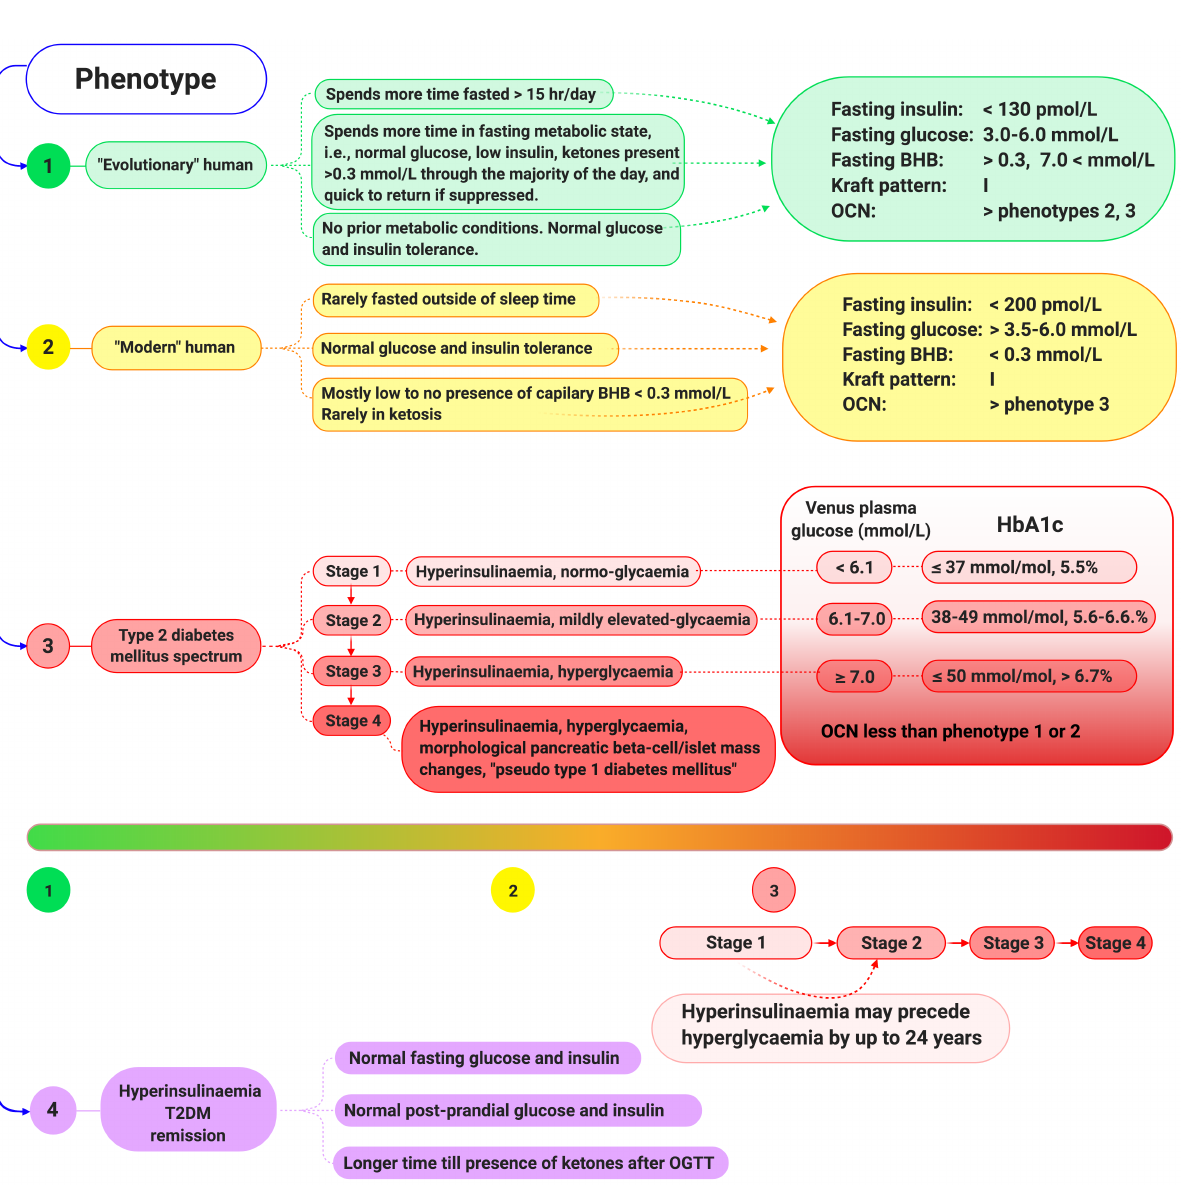
Figure 3. Classification of metabolic phenotypes. Beta-Hydroxybutyrate (BHB), haemoglobin A1c (HbA1c), oral glucose tolerance test (OGTT), osteocalcin (OCN), type 2 diabetes mellitus